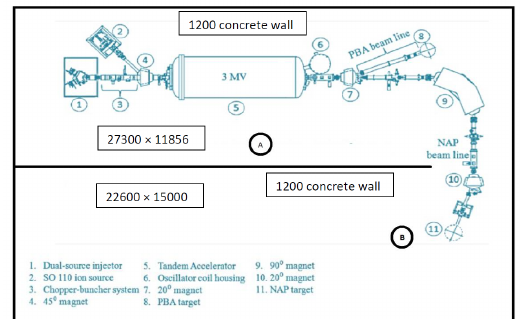
Figure 2. Schematic sketch of FRENA indoor buildings and the machine parts. spot A and spot B are the positions of the detectors at the Accelerator hall and the Beam hall for the background γ -ray measurement. Dimensions are in